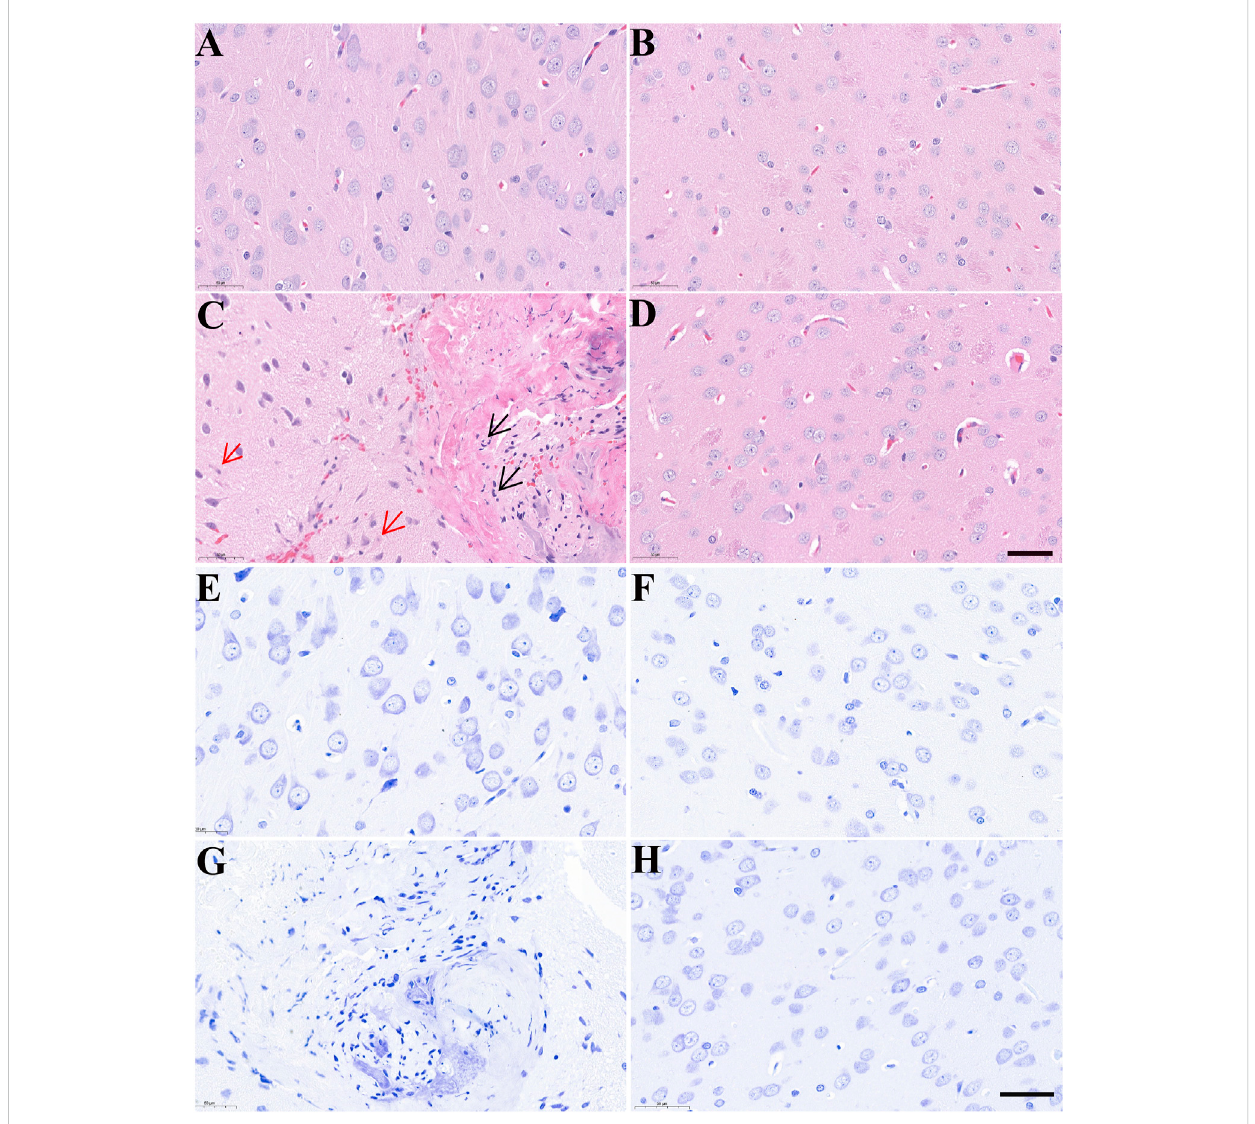
FIGURE 4 The effects of Alangium chinense combined with the compatible herbs of JGL on the morphological structure of neurons in the brain. Rats were orallygavagedwithdistilledwater (controlgroup, AandE),extractofcompatibleherbsofJGL(CHgroup,BandF), Alangiumchinense extract (ACgroup, C and G), a combination of AC and CH (AC/CH group, D and H) once-daily for 14 days. Scale bar = 50 μ m in H&E (A – D) and Nissl staining (E – H) . Black arrows indicated nucleus pycnosis, karyorrhexis and neuronal necrosis. Red arrows indicated neuronal eosinophilic